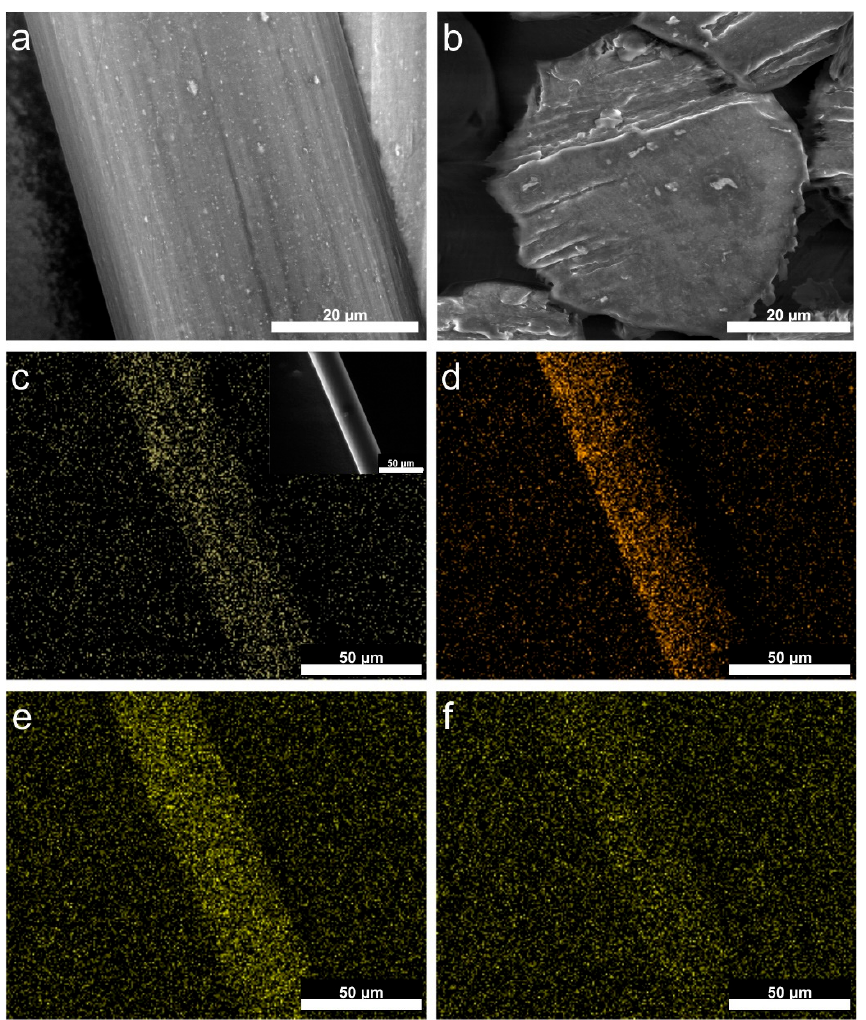
Figure 2. SEM-EDX analysis: ( a ) SEM images of the fibers surface and ( b ) cross-section; ( c ) EDX- mapping of yttrium, ( d ) fluoride, ( e ) ytterbium, and ( f ) erbium; inset presents the field of view.